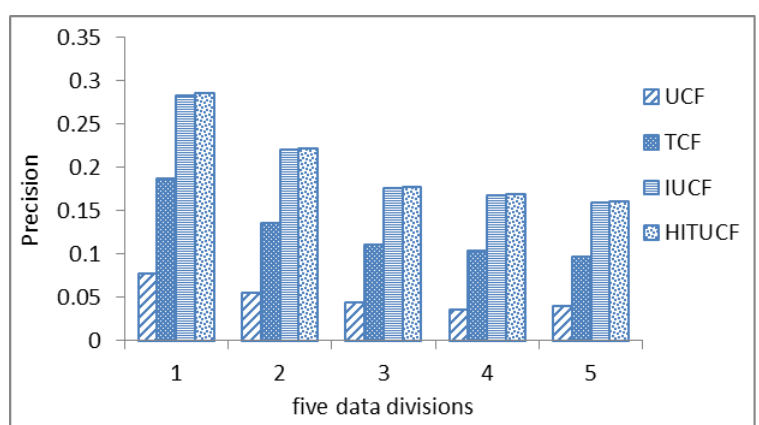
Figure 14. Precision of five data divisions.